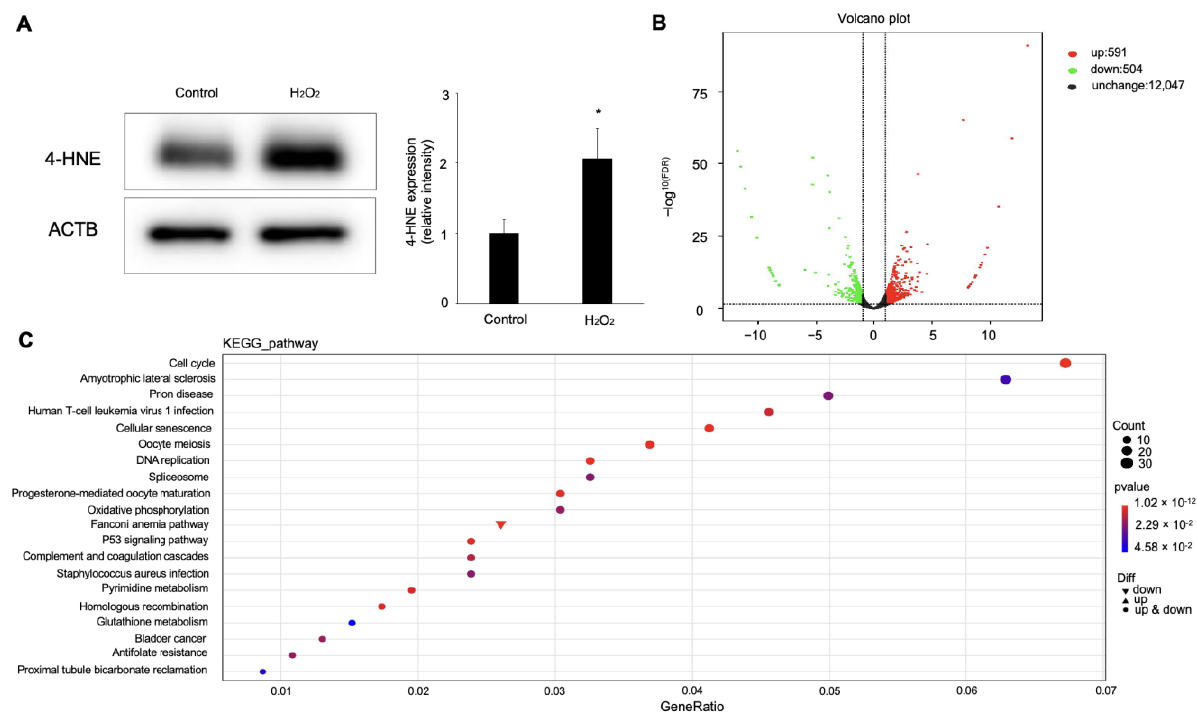
Figure 4. Differential-expression analysis of ARPE-19 cells with hydrogen peroxide stimulation. ( A ) Western blot analysis for 4-HNE in ARPE-19 cells treated with 100 μ M hydrogen peroxide. n = 3 in each group. * p < 0.05. ( B ) Visualization of RNA-Seq results with Volcano plot. ( C ) KEGG-pathway classification for differentially expressed genes.